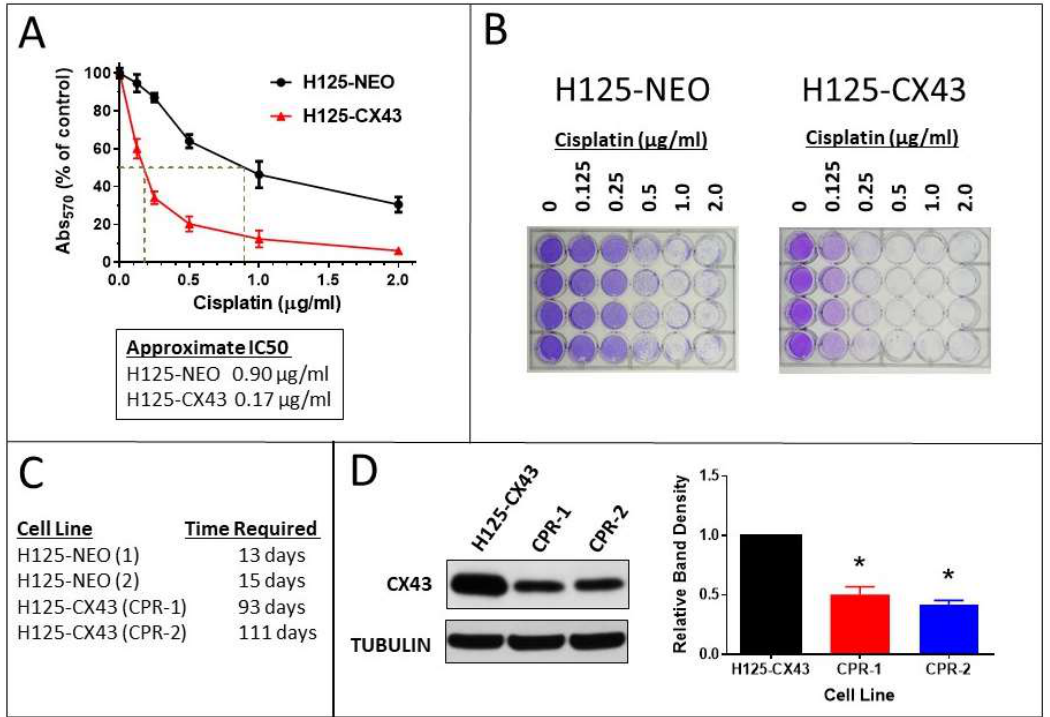
Figure 5. Connexin43-expressing H125 cells exhibit increased cytotoxicity and reduced ability to develop resistance to cisplatin. ( A , B ) The cisplatin concentration–response curves indicated approximately five-fold greater drug toxicity in H125-CX43 cells (mean ± S.D., n = 4 replicate experiments). ( C ) A longer duration of exposure was required to develop resistance to 2 µg/mL cisplatin in two separate trials with each cell line. ( D ) Western blot of Cx43 in cisplatin-naïve (H125-CX43) and resistant cells (CPR-1 and CPR-2); band densities were normalized to tubulin loading control and to H125-CX43 (* p < 0.01 compared to H125-CX43, one-sample t -test, mean ± S.D., n = 4 replicate experiments).